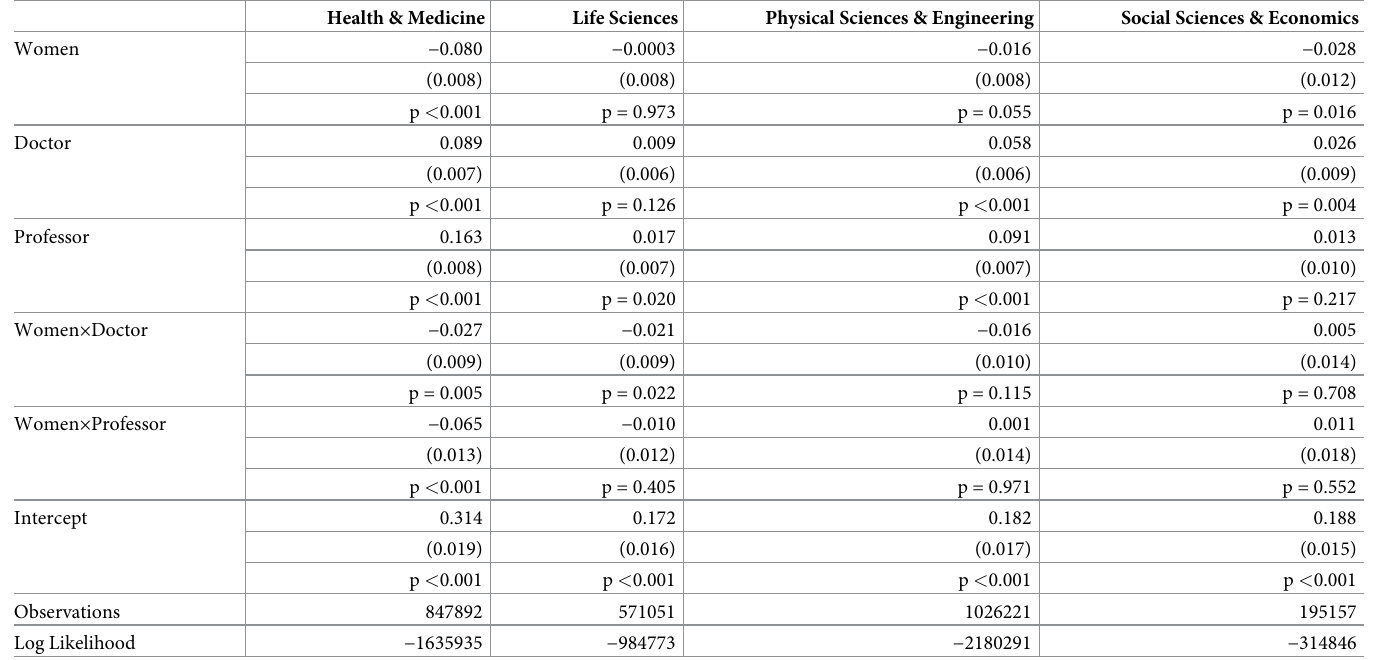
Table 3. Mixed effects models predicting February-May 2020 changes in the number of submissions per area of